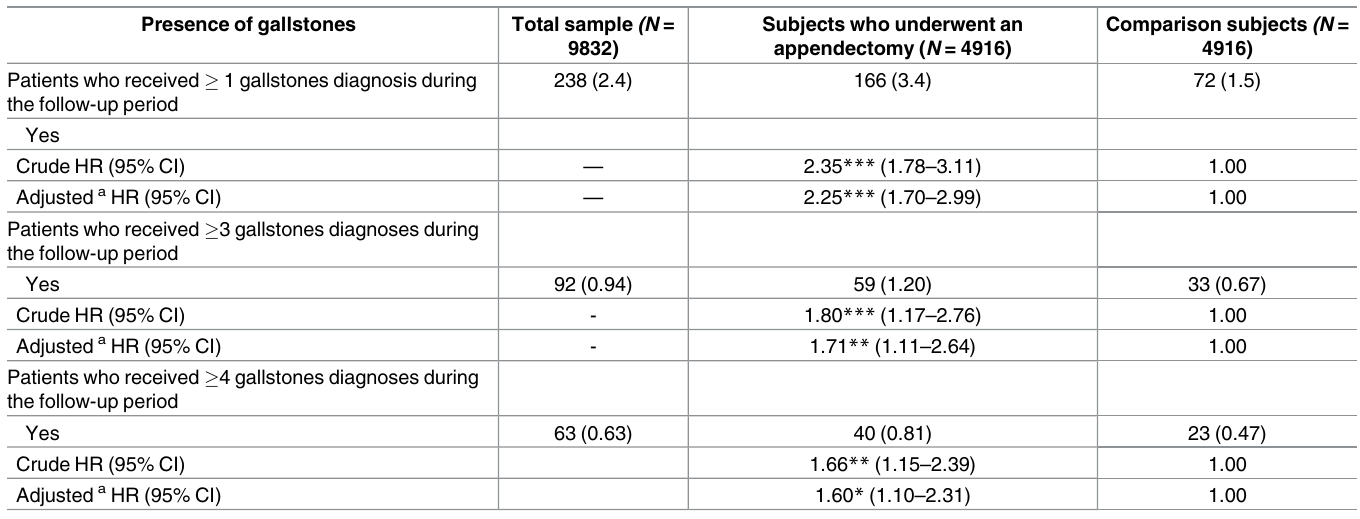
Table 4. Sensitivity